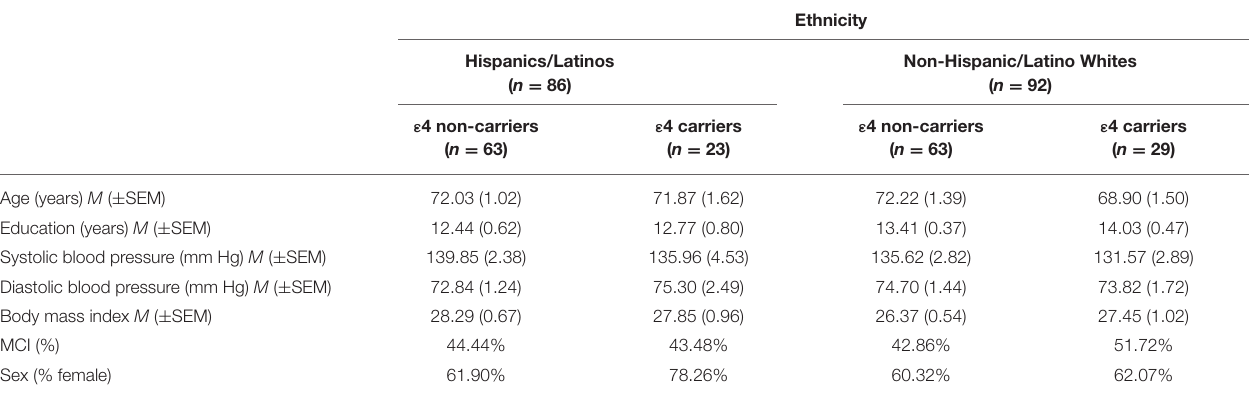
TABLE 1 | Combined Alzheimer’s disease neuroimaging initiative (ADNI) and National Alzheimer’s Coordinating Center (NACC) sample demographics organized by ethnicity and the APOE ε 4